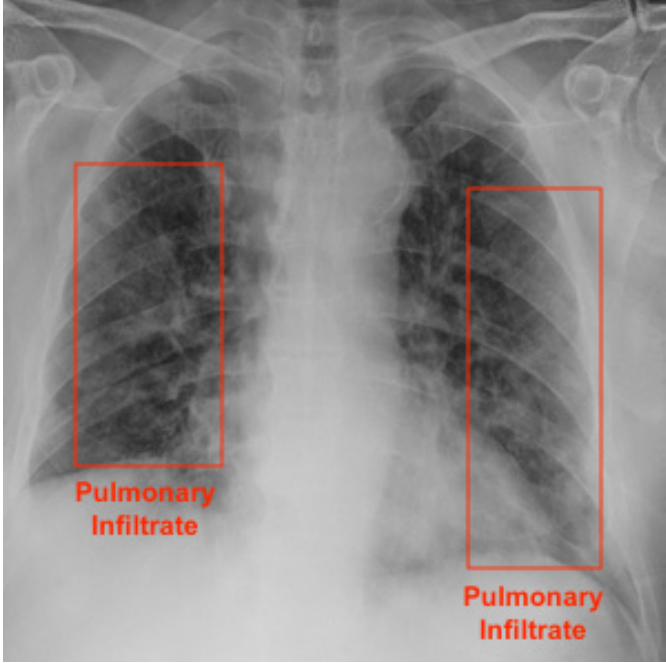
Figure 1. COVID-19 patient is male and 73 years old. Bounding box highlights infiltrates. A chest CT scan combines data from multiple X-rays taken from different angles, which produces a detailed image of the lungs. CT scans are more effective than chest X-ray in early stages of COVID-19 disease detection. They have been used as a tool to diagnose and monitor the progression of the disease [9]. More than 70% of chest CT scans in patients with RT-PCR test-proven COVID-19 cases report ground-glass opacities, vascular enlargement, bilateral abnormalities, lower lobe involvement, and posterior predilection [10]. Figure 2 illustrates those abnormalities. Studies by [11,12] confirm that patients with COVID-19 pneumonia have ground-glass opacities in the earlier stages of the disease and pulmonary consolidation in later stages. Eventually, a rounded morphology and a peripheral pul- monary distribution are observed. Those abnormalities are analogous to those observed in other coronavirus infections, such as SARS-CoV-1 and MERS-CoV [13]. Although typical images can help in the early screening of suspected cases, images of various viral pneumonias are similar and overlap with other infectious and inflamma- tory lung diseases. Therefore, it is not trivial for radiologists to distinguish COVID-19 pneumonia from other viral pneumonias. AI algorithms are a valuable tool to support this task. It is important to notice that the WHO and the American Society of Radiology do not recommend the use of radiology images as the principal diagnostic method for COVID-19